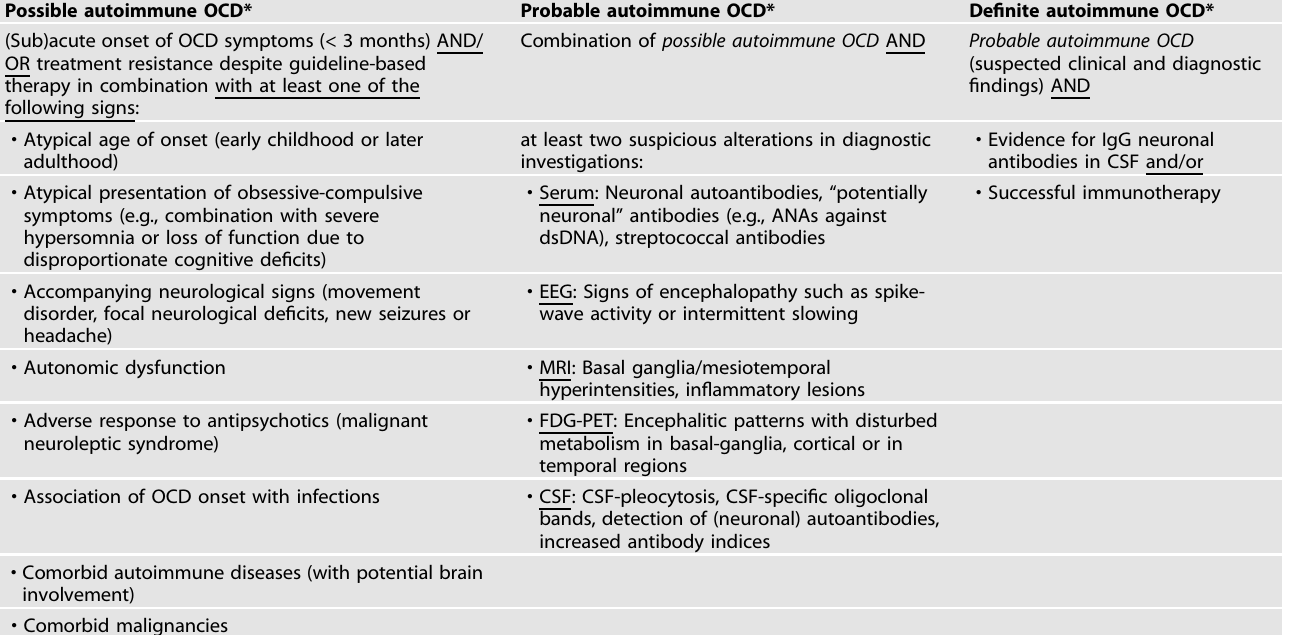
Table 4. Preliminary criteria of possible, probable, and de fi nite autoimmune obsessive-compulsive disorders suggested by the authors. Possible autoimmune